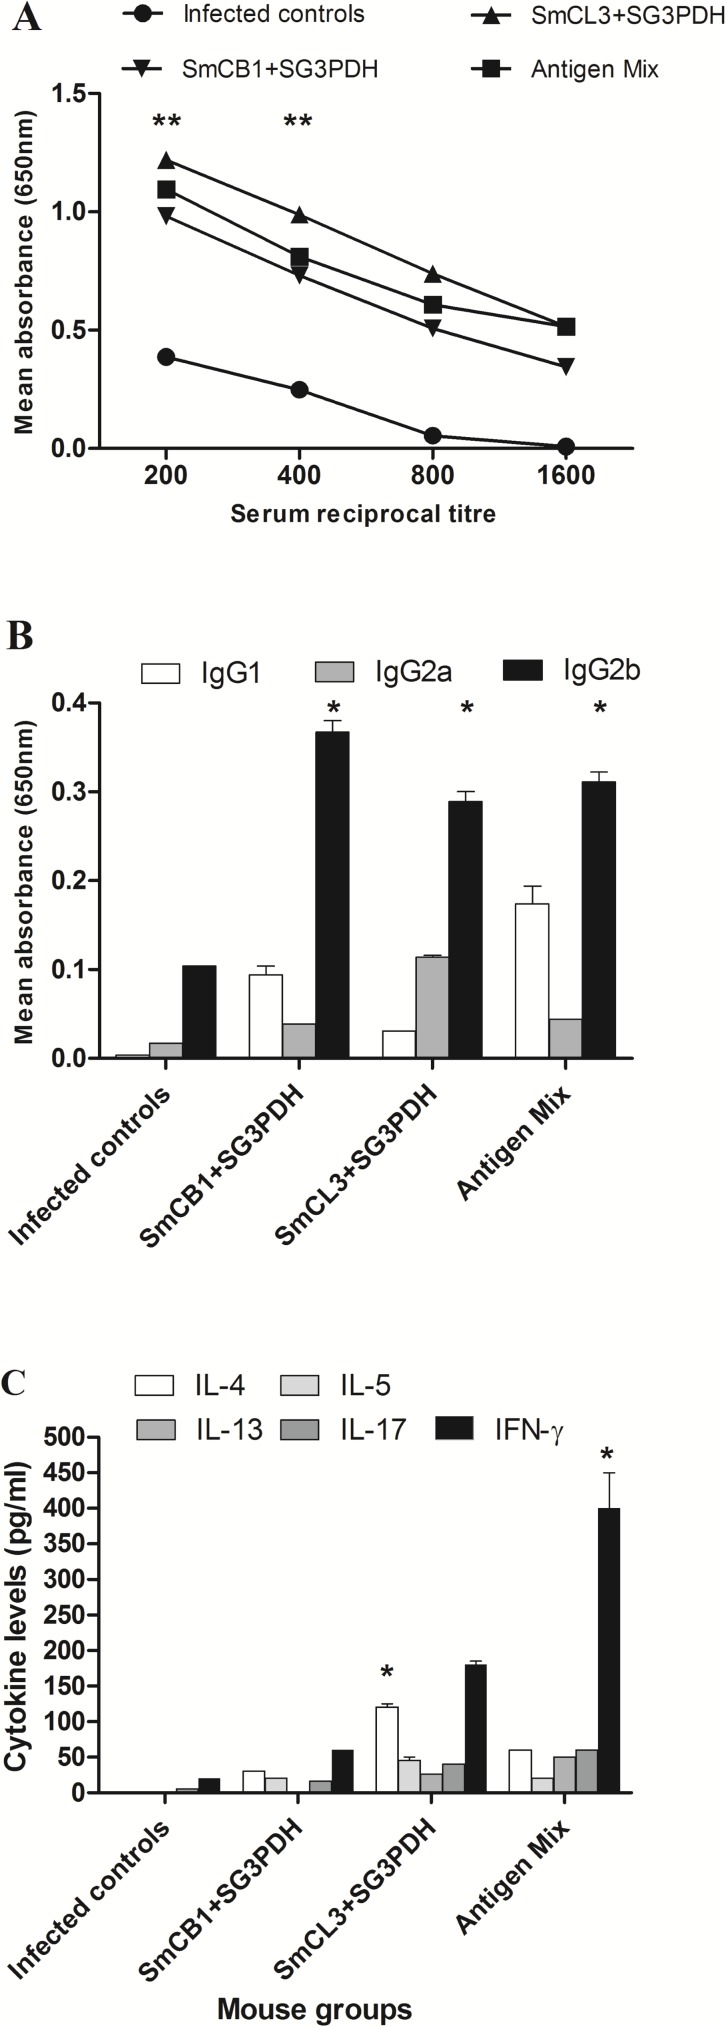
Mouse serum antibody and cytokine response to SG3PDH delivered with cysteine peptidases.Sera taken from control and immunized [SmCB1+ SG3PDH, SmCL3+ SG3PDH and SmCB1+SmCL3+ SG3PDH (Antigen Mix)] mice obtained 7 days after challenge S. mansoni infection were analyzed for antibody titers (A) and isotype (B) to SG3PDH in ELISA. Spleen cells obtained at the same time point were analyzed for cytokine responses following in vitro stimulation with 0 or 20 μg/ml SG3PDH (C). Each point or column represents mean values +/- SD for three mice per group. Asterisks indicate significance (* P < 0.05, ** P < 0.005) of differences between immunized & infected and control-infected mice.